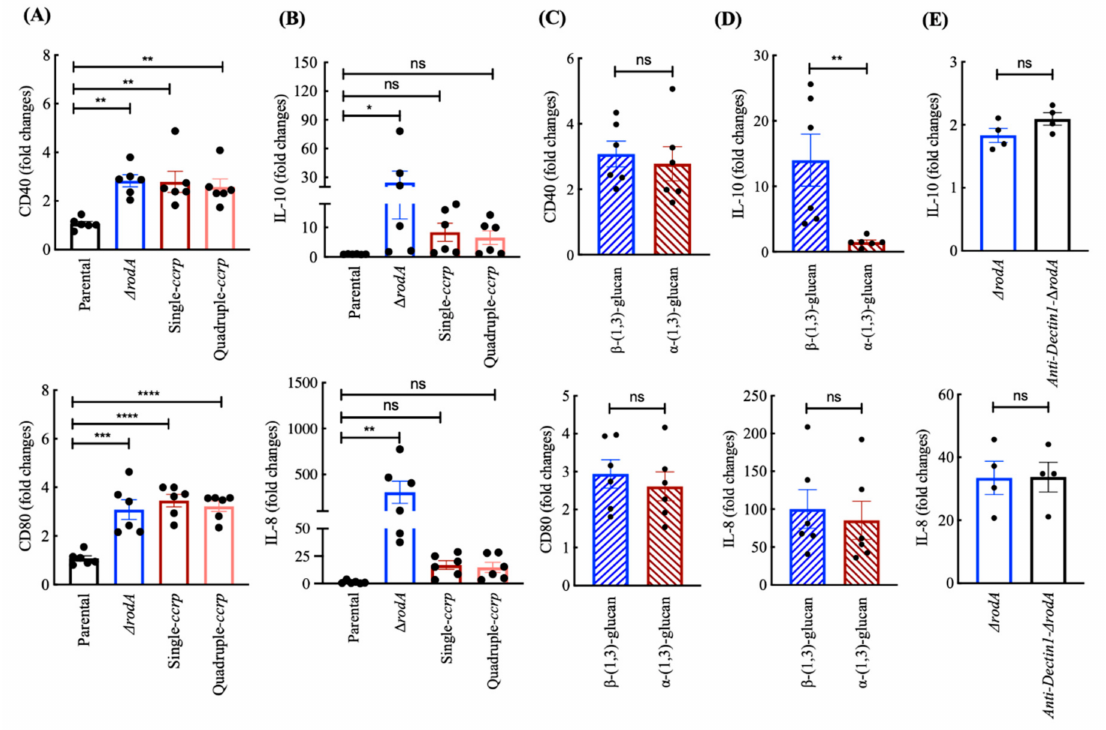
Figure 5. Conidial immunostimulatory capacities: ( A ) monocyte-derived DCs were cultured either in medium alone or with dormant conidia, ∆ rodA or ccrp-mutant conidia for 48 h. The expression of CD80 and CD40 on DCs was analyzed by flow cytometry. Data (mean ± SEM, n = 6 donors) are presented as fold changes in the median fluorescence intensity compared to untreated DCs. ( B ) Fold changes (mean ± SEM, n = 6 donors) in the IL-10 and IL-8 amounts in the cell-free culture supernatants compared to untreated control DCs. Statistical significance as determined by one-way ANOVA; * p < 0.05, ** p < 0.01, *** p < 0.001 **** p < 0.0001 and ns, not significant. ( C , D ) Comparison of the DC-stimulatory functions of β -(1,3)-glucan and α -(1,3)-glucan. DCs were stimulated with isolated α -(1,3)-glucan or β -(1,3)-glucan for 48 h and analyzed for the expression of CD80 and CD40 ( C ) and the secretion of IL-10 and IL-8 ( D ). Data (mean ± SEM, n = 6 donors) are presented as fold changes in the cytokines compared to untreated control DCs. Statistical significance as determined by two-way Mann-Whitney U -test; ** p < 0.01 and ns, not significant. ( E ) DCs were treated with an anti-Dectin-1 MAb followed by stimulation with ∆ rodA conidia. Cytokines (IL-10 and IL-8) in the cell-free culture supernatants were quantified and data (mean ± SEM, n = 2 donors in duplicates) are presented as fold changes in cytokines compared to untreated control DCs. Statistical significance as determined by two-way Mann-Whitney U -test; ns, not